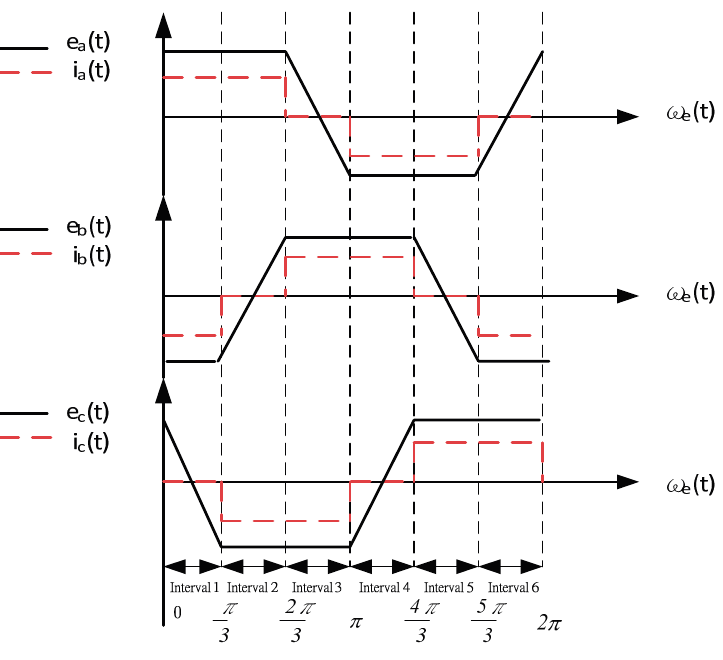
Figure 2. Three-phase rectifier circuit waveform timing diagram at fixed DC